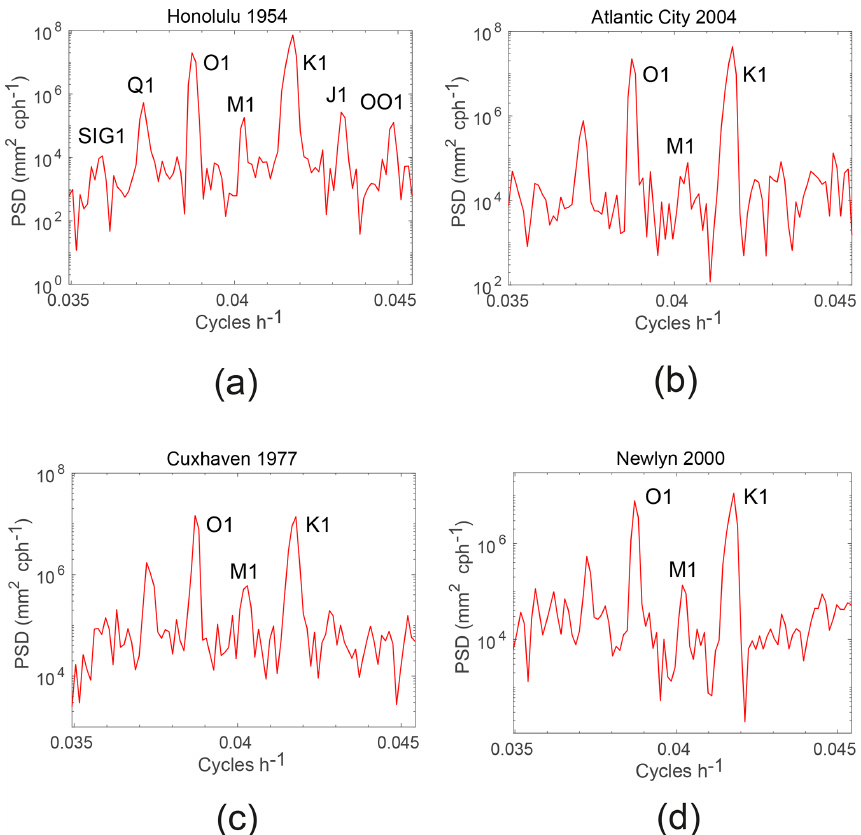
Figure 3. (a) Power spectral density (PSD) within the diurnal section of a spectrum of one year of sea level data from Honolulu, Hawaii showing the lines of the main diurnal tides. (b, c, d) The corresponding spectra from Atlantic City, Cuxhaven and Newlyn